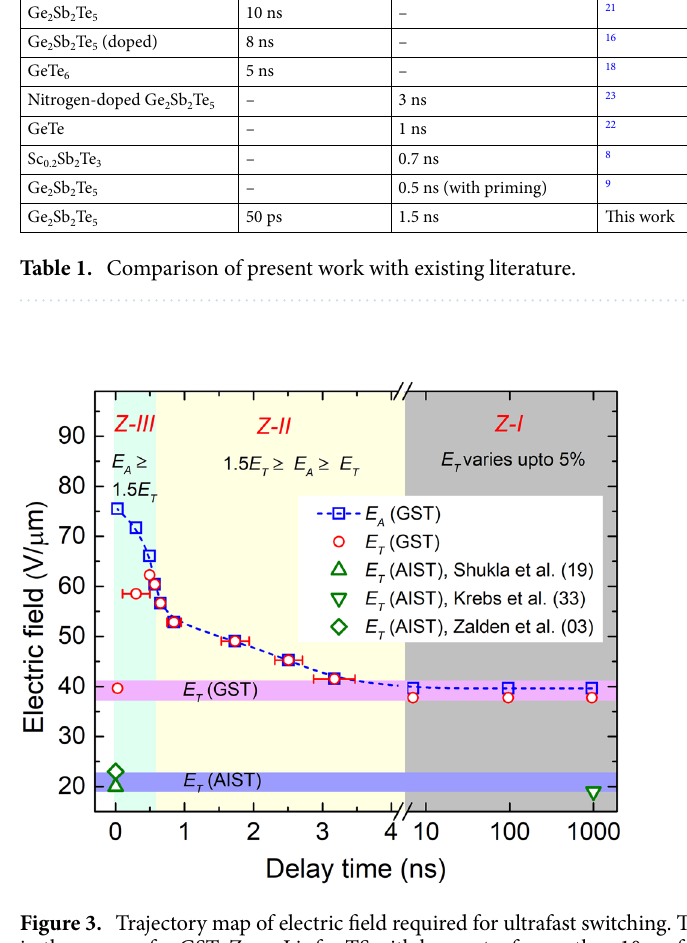
Figure 3. Trajectory map of electric field required for ultrafast switching. Threshold electric field is categorized in three zones for GST: Zone-I is for TS with longer t d of more than 10 ns, for the E A almost equal to E T . Zone-II is for E A between E T and 1.5 times of E T where the device switches within the plateau region of the pulse, and data points of E A and E T coincides. Zone-III is for E A more than 1.5 times E T , where device switches within the leading edge of the pulse. This behavior of threshold switching in GST device is quite different than that